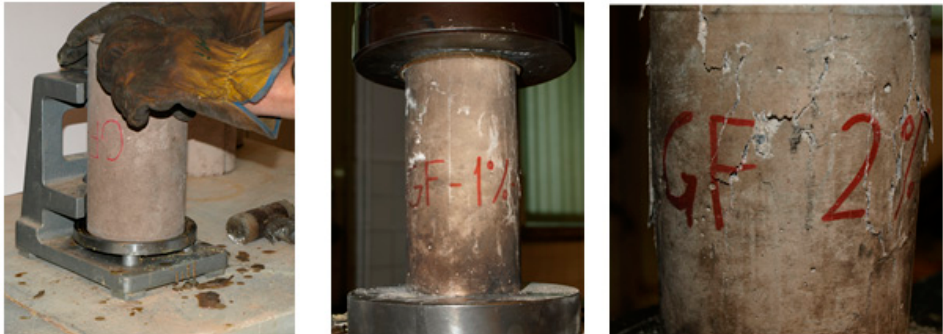
Figure 3. Capping of test pieces and compression testing to breaking point.